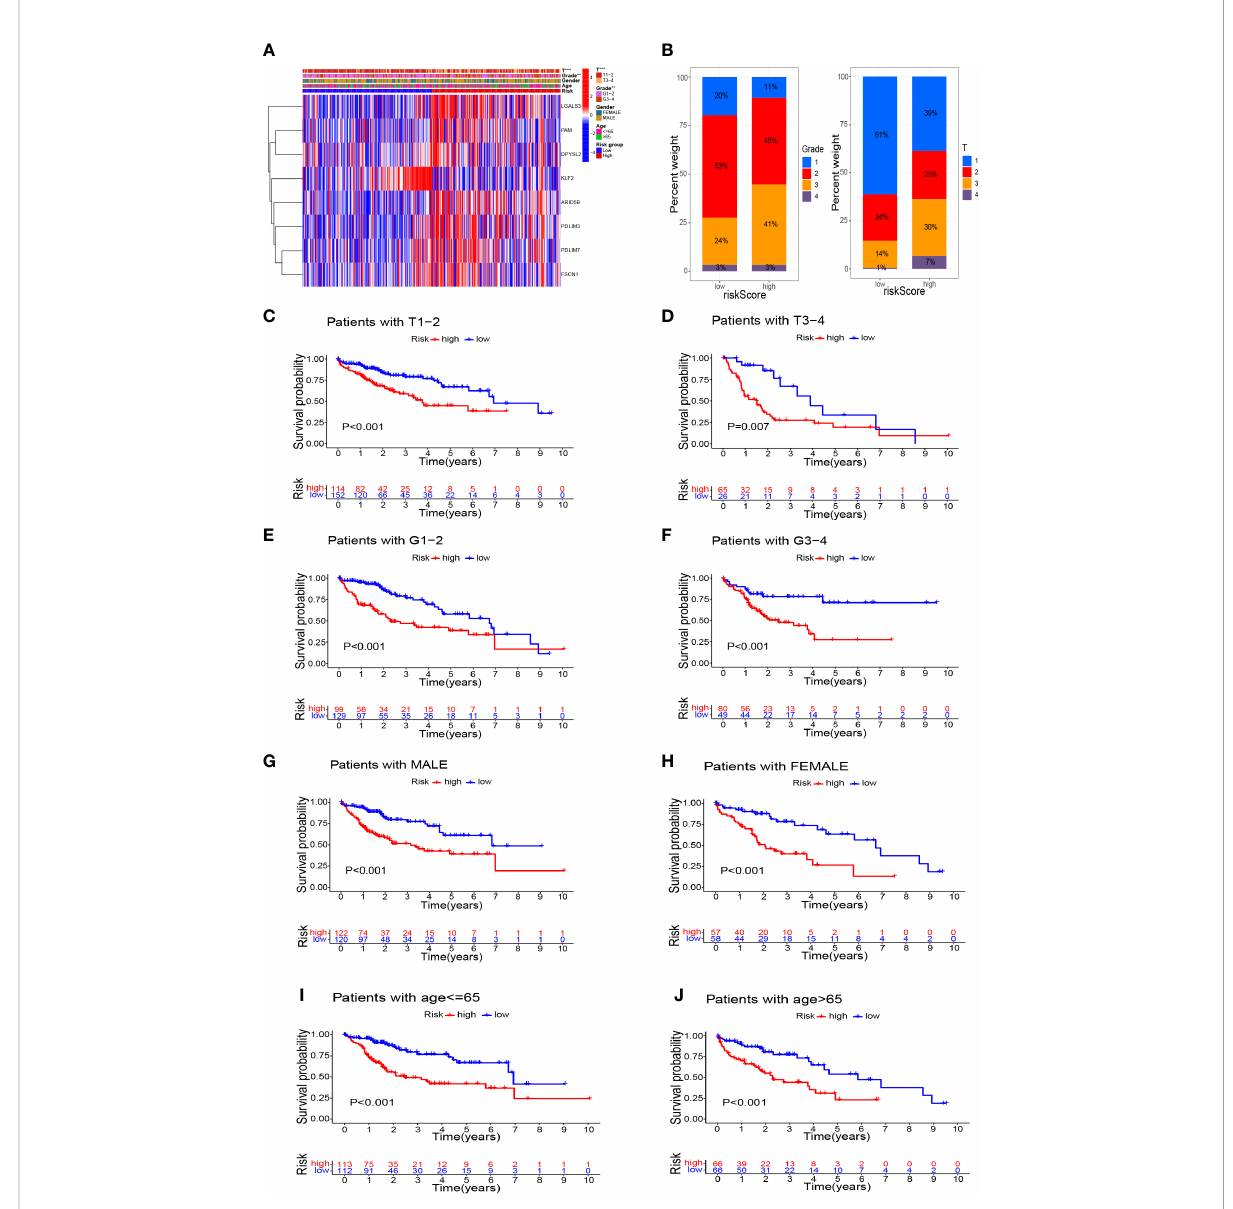
FIGURE 7 Survival analysis based on strati fi cation of clinicopathological characteristics. (A) Heatmap demonstrated the differences in gene expression and clinicopathological features between high-risk and low-risk groups. (B) Histograms related to clinicopathological features. Kaplan – Meier survival curves illustrated the results of survival analysis strati fi ed by T stage (C, D) , tumor grade (E, F) , sex (G, H) , and age (I, J) . **P<0.01,